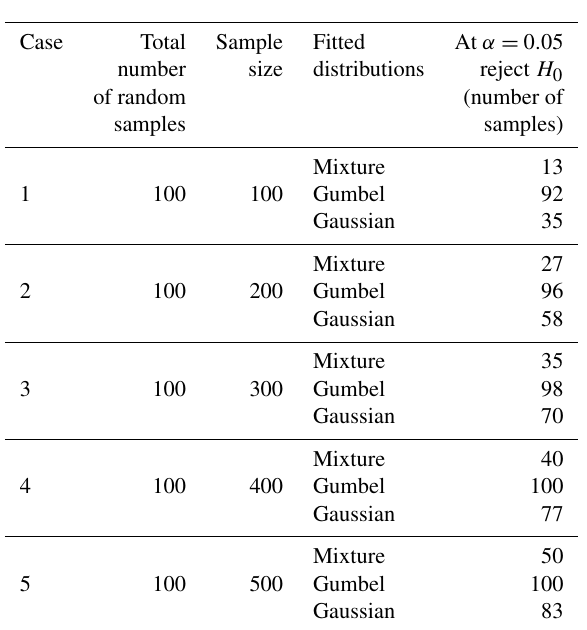
Table 1. For each sample size, the number of samples with the null hypothesis H 0 rejected at α = 0 . 05 for all the distributions.